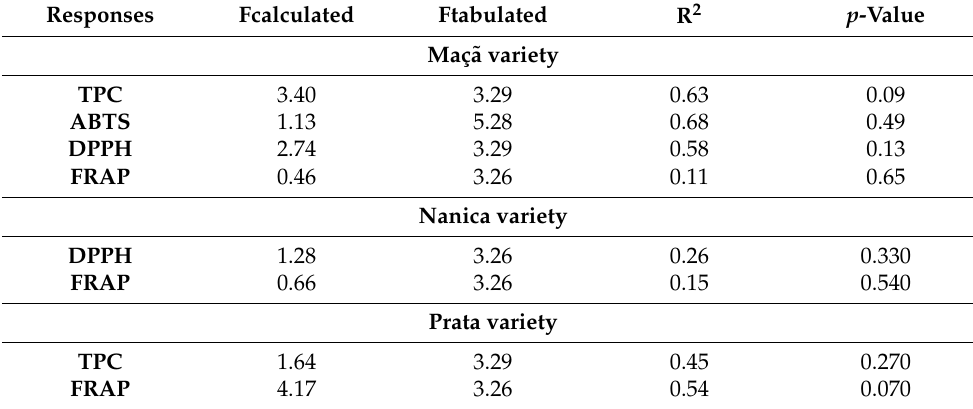
Table 4. Statistical parameters including F-test, R 2 and probability values for TPC and antioxidant activities (ABTS, DPPH and FRAP) from the extract of banana bract extracts (Maç ã , Nanica and Prata varieties), that did not generate statistically valid